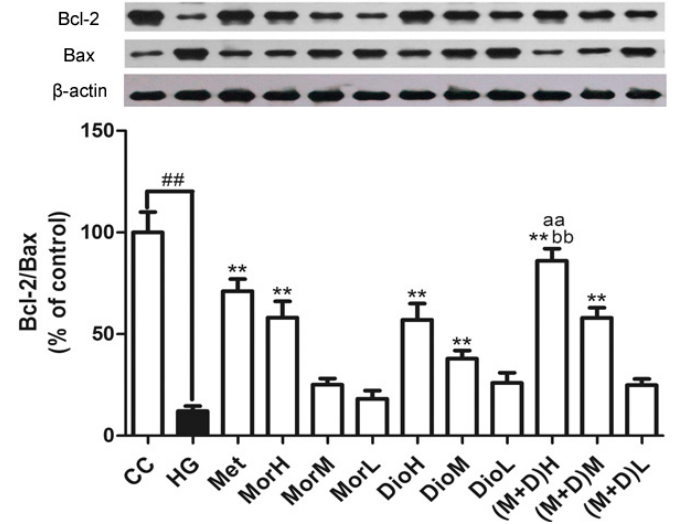
Figure 4. Regulation of proteins Bcl-2 and Bax associated with apoptosis by MorH, DioH, and (M + D)H. Data are expressed as mean ± SD. ## p < 0.01 vs. CC; ** p < 0.01, vs. HG; aa p < 0.01, vs. MorH; bb p < 0.01, vs. DioH.